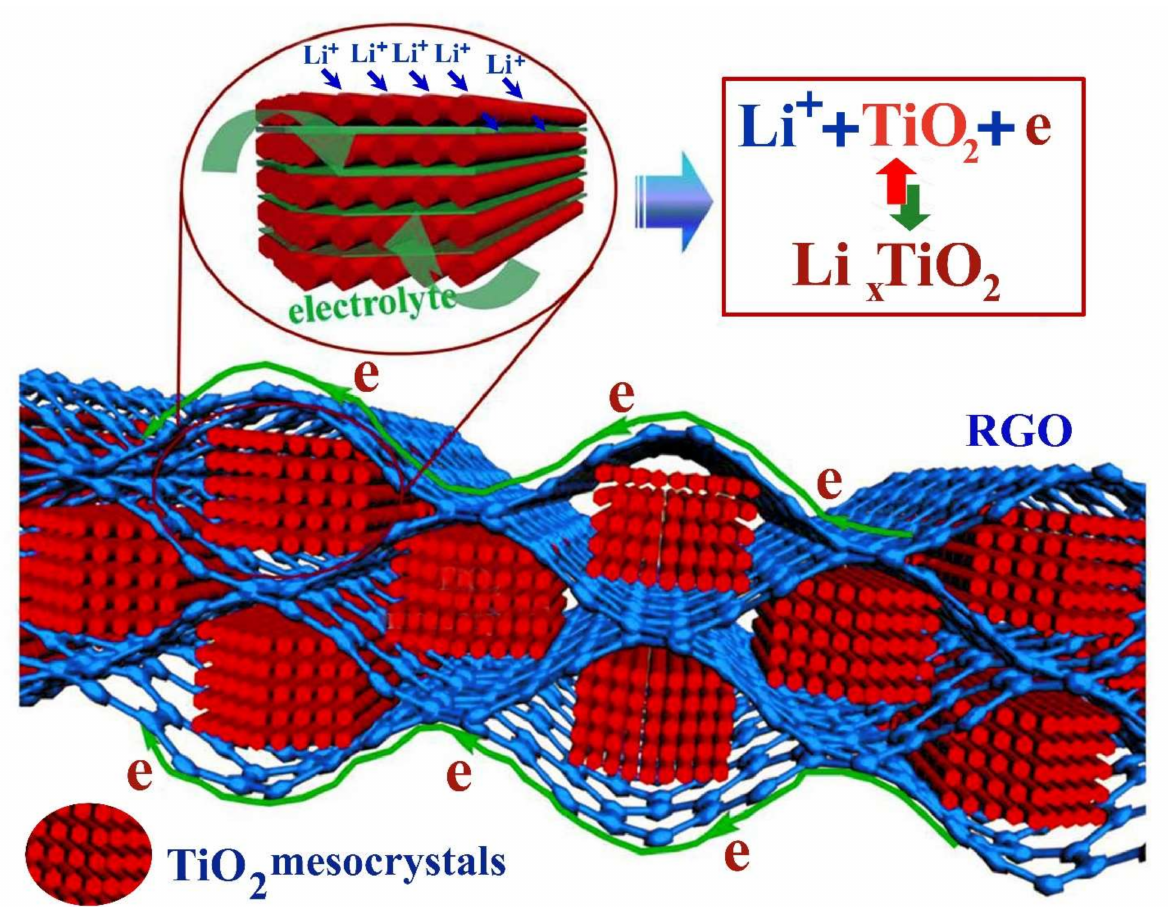
Figure 18. Schematic representation of the transport path of lithium ions and electrons in the theTiO 2 /graphene hybrids where TiO 2 with tiny subunits enclosed in highly conductive graphene oxide nanosheet (TGR) hybrids. Adapted and reproduced with permission from Ref. [84]. Copyright 2015